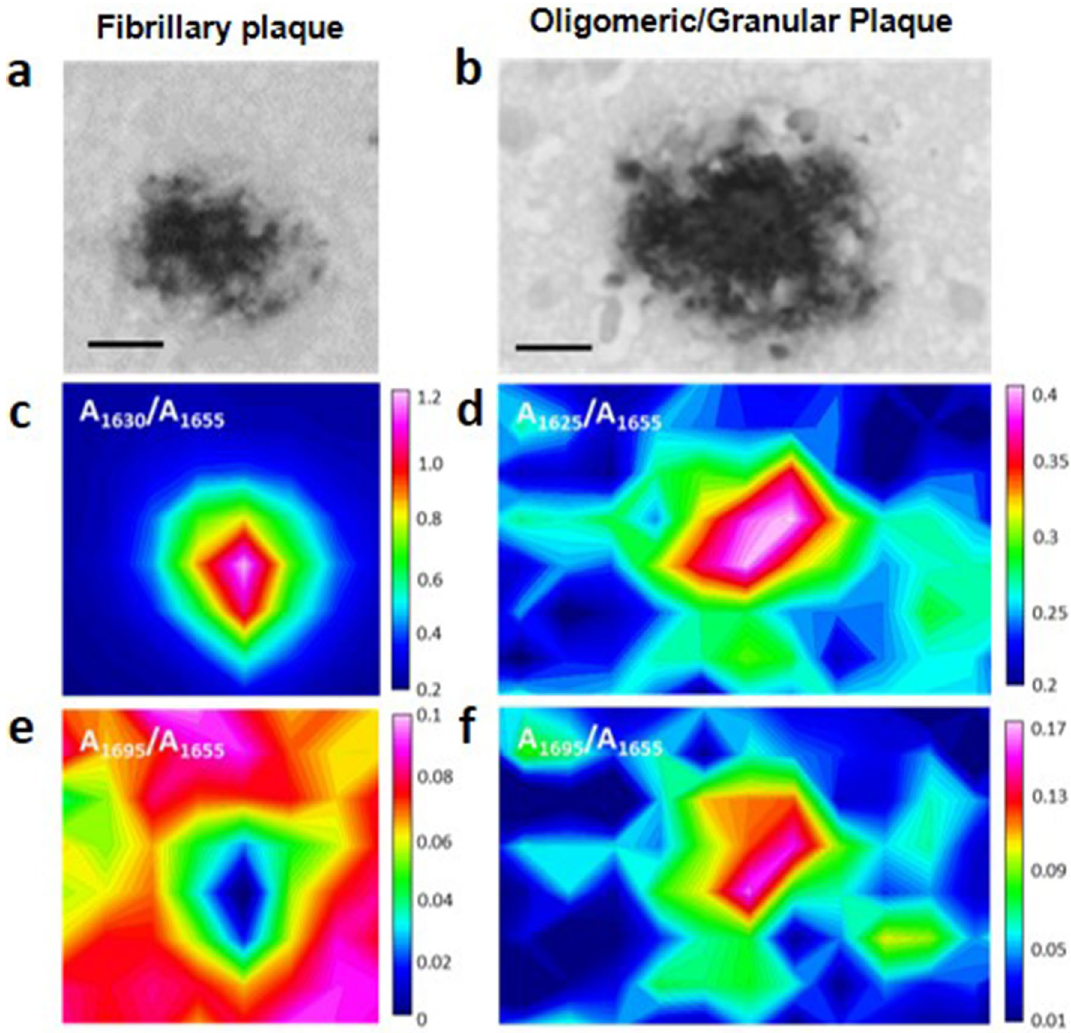
Figure 4. Representative infrared and visible maps of a fibrillary plaque (left panels) and an Oligomeric/ Granullar plaque (right panels). (Top row) Images in the visible region of the plaque labeled with an antiamyloid antibody in a contiguous brain slide; (Midle row) absorbance ratios corresponding to fibrillary β-sheet amyloid aggregation; (Bottom row) absorbance ratios corresponding to antiparallel β-sheet aggregation distribution. Ratios were calculated from the second derivative spectra. Scale bar = 10 μm. Opus 7.5 (Bruker) software was used for the maps